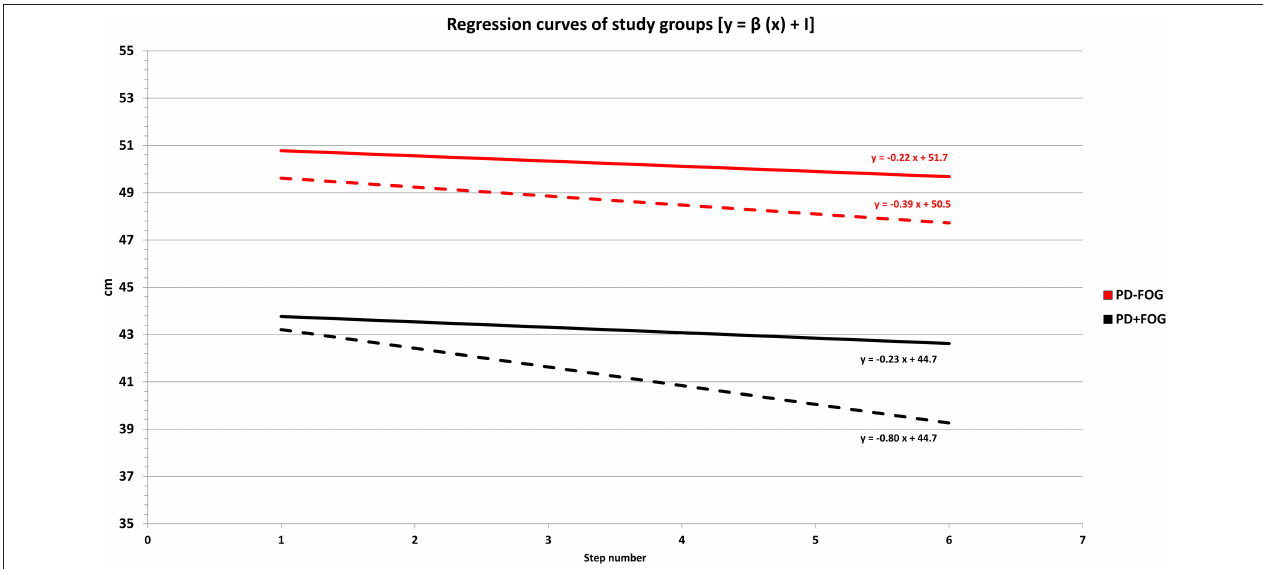
FIGURE 2 | Regression curves of study groups before (T0) and after (T1) the 4-week rehabilitation program. PD + FOG: patients with Parkinson’s disease with freezing of gait (black lines— n = 23). PD – FOG: patients with Parkinson’s disease without freezing of gait (red lines— n = 20). The length of the last six steps ( y -axis) ahead of the final stride of gait was plotted against step number ( x -axis). The linear regression slope ( β ) was calculated as a measure of the destination sequence effect (dSE). The intercept ( I ) of the regression curve represented an indirect measure of gait hypokinesia. For each group, the relationship between gait hypokinesia and sequence effect is expressed by the function of the linear regression as follows: y = β ( x ) + I . Dashed lines: regression curves of study groups at T0 (hospital admission). Continuous lines: regression curves of study groups at T1 (end of the 4-week rehabilitation program—hospital discharge). Descriptively, at T0 (hospital admission) the PD + FOG group (black dashed line) was characterized by a greater negative slope (more pronounced dSE) and a lower position (reduced step length and pronounced gait hypokinesia) when compared to the PD – FOG group (red dashed line). At the end of the 4-week rehabilitation program (T1), we found a reduction of the linear regression slope ( β ), which is consistent with a dSE improvement in the overall study population. This improvement was more pronounced in the PD + FOG group (black continuous line), leading to a slope of the regression curve almost parallel to the PD – FOG group (red continuous